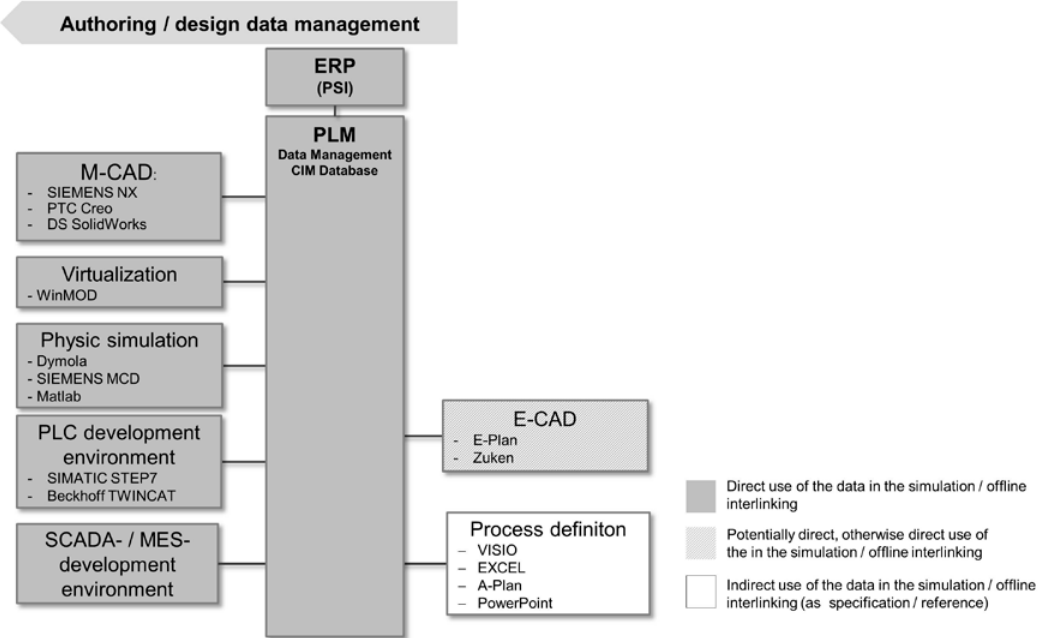
Figure 4. Development applications connected to the PLM-solution.